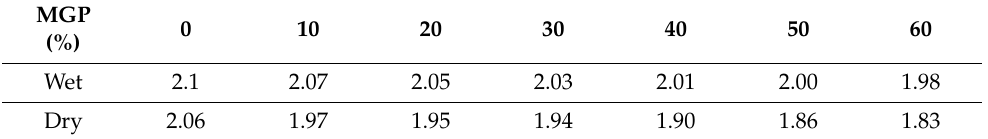
Table 3. Measured densities of the mortar glass powder (MGP) samples in the dry and saturated